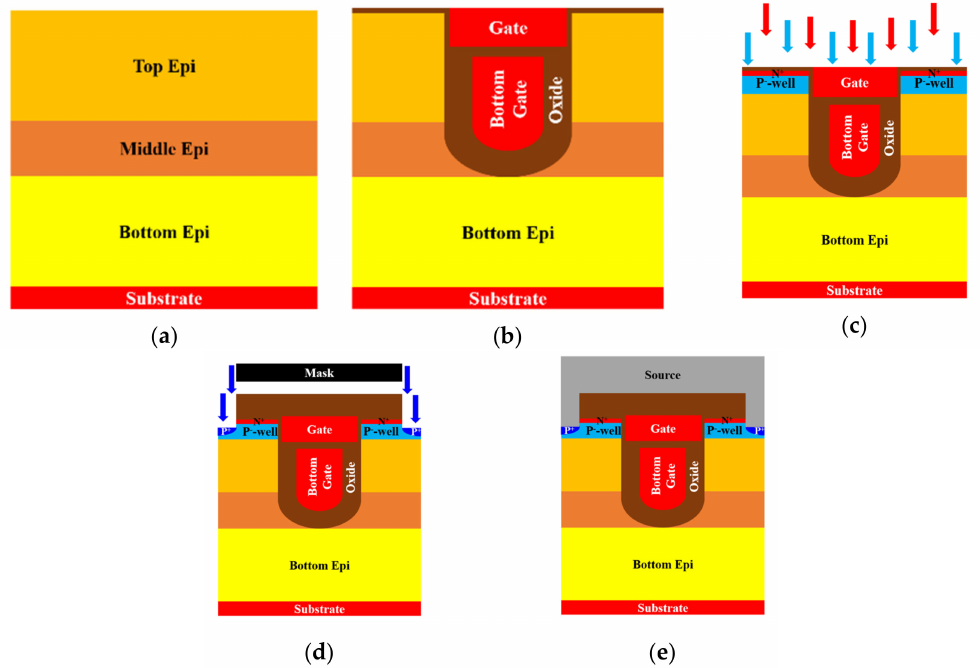
Figure 2. Main simulated fabrication process for the triple-EPIs SGT power MOSFET: ( a ) three designed epitaxial layers; ( b ) defining the trench, bottom gate, and gate; ( c ) forming the channel and the source areas; ( d ) opening the contact holes and implanting the p + ; ( e ) depositing the metal pads.